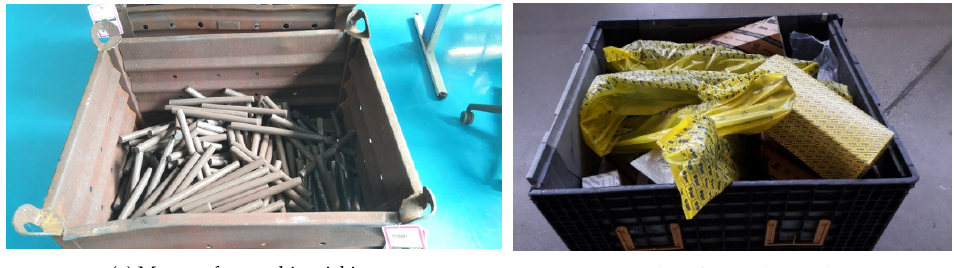
Figure 1. Random bin-picking